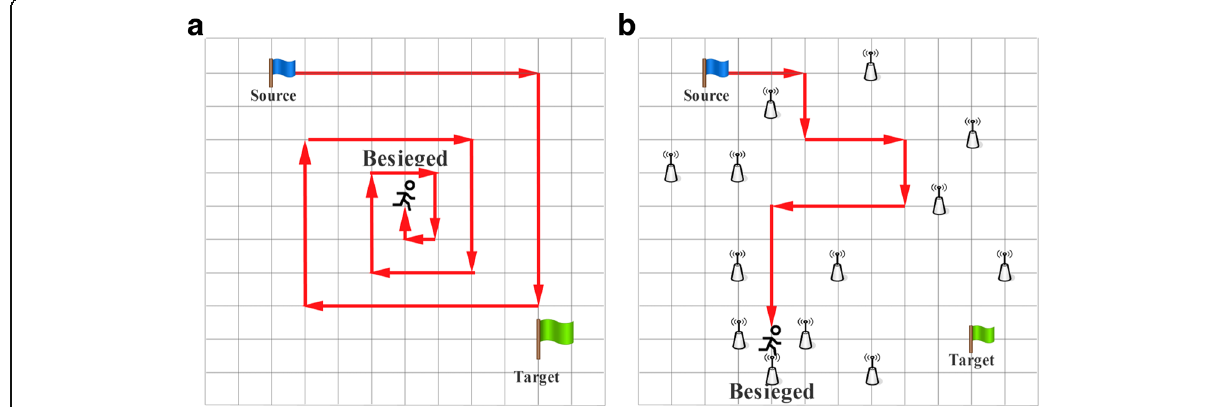
Fig. 2 The diagram of the besieged walker, where a shows the walker is besieged by the path visited before, b shows the walker is besieged by